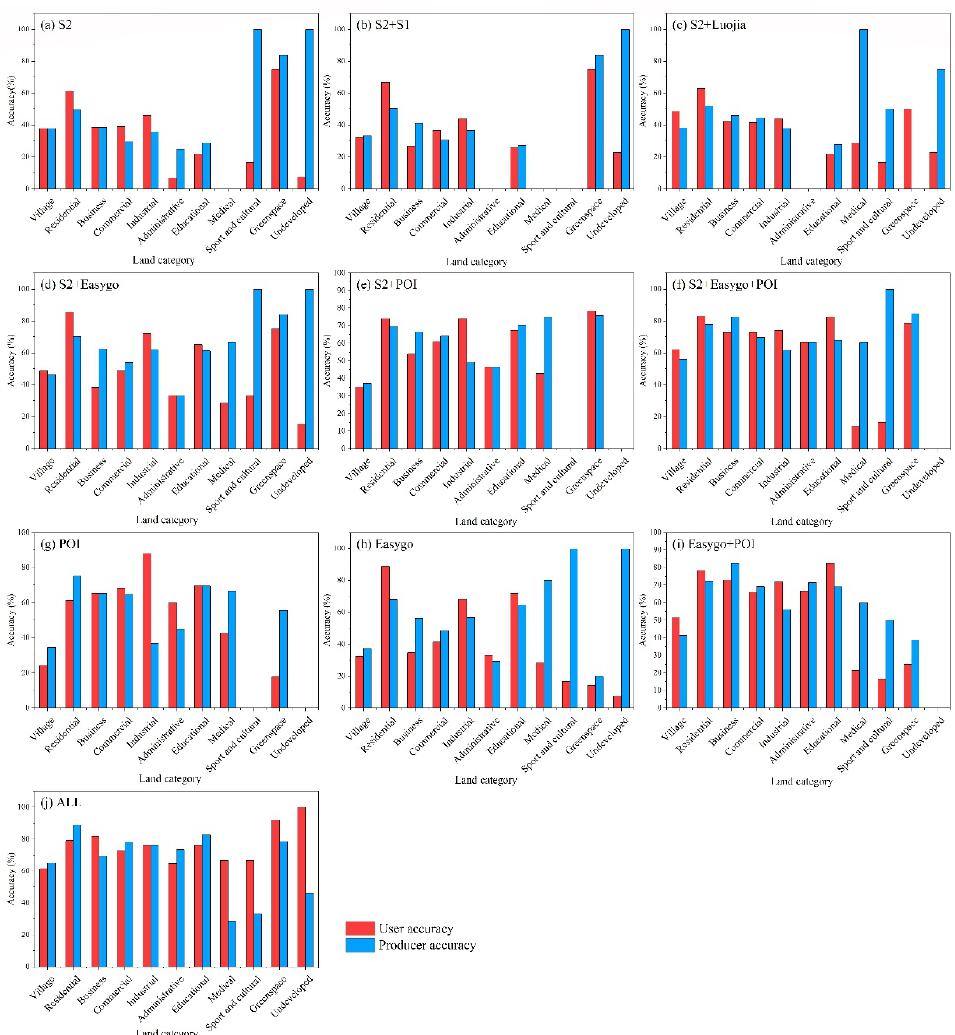
Figure 7. User accuracy and producer accuracy of different land use classes based on different feature combinations (Level II category).